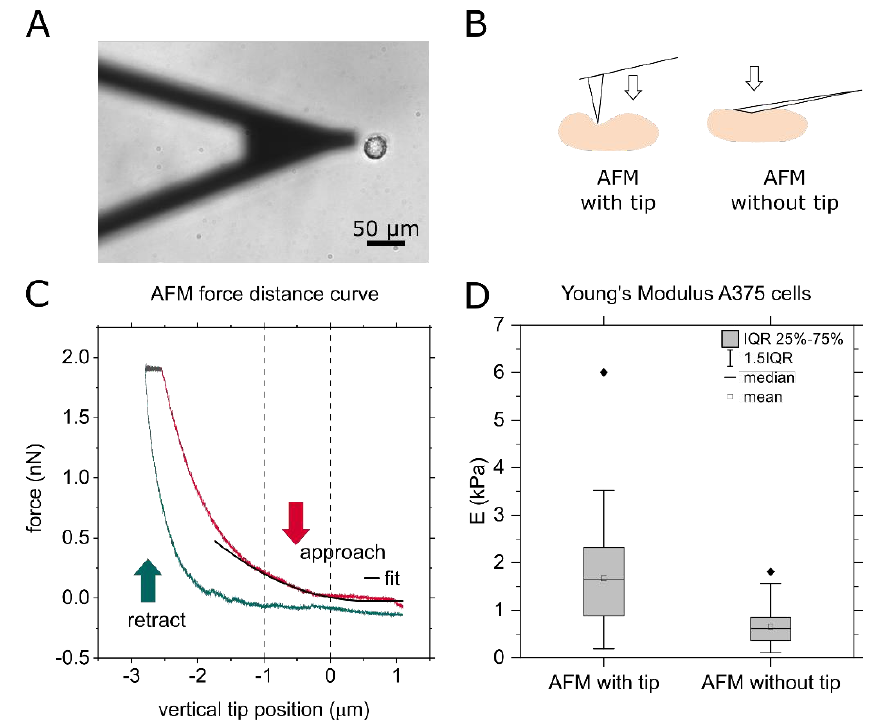
Figure 1. ( A ) Micrograph of a cantilever without tip approaching an adherent A375 cell. ( B ) Principle AFM with and without tip. ( C ) Force–distance curve of an exemplary measurement with cantilever stiffness k = 0.03 N/m, force set point f = 2 nN, approaching speed v = 1 µm/s and approaching distance d = 5 µm. The pause between approach and retract is 1 s at constant force. ( D ) Comparison of AFM force spectroscopy results of the Young’s modulus of A375 cells using a cantilever with tip and one without tip. The boxplot summarizes the results on about 50 cells with approximately ten force curves per cell of AFM measurements with and without tip. The cantilever without tip is 20 μm wide at the front, and the tip radius of the approximately 3 μm long tips used here is 20 nm.